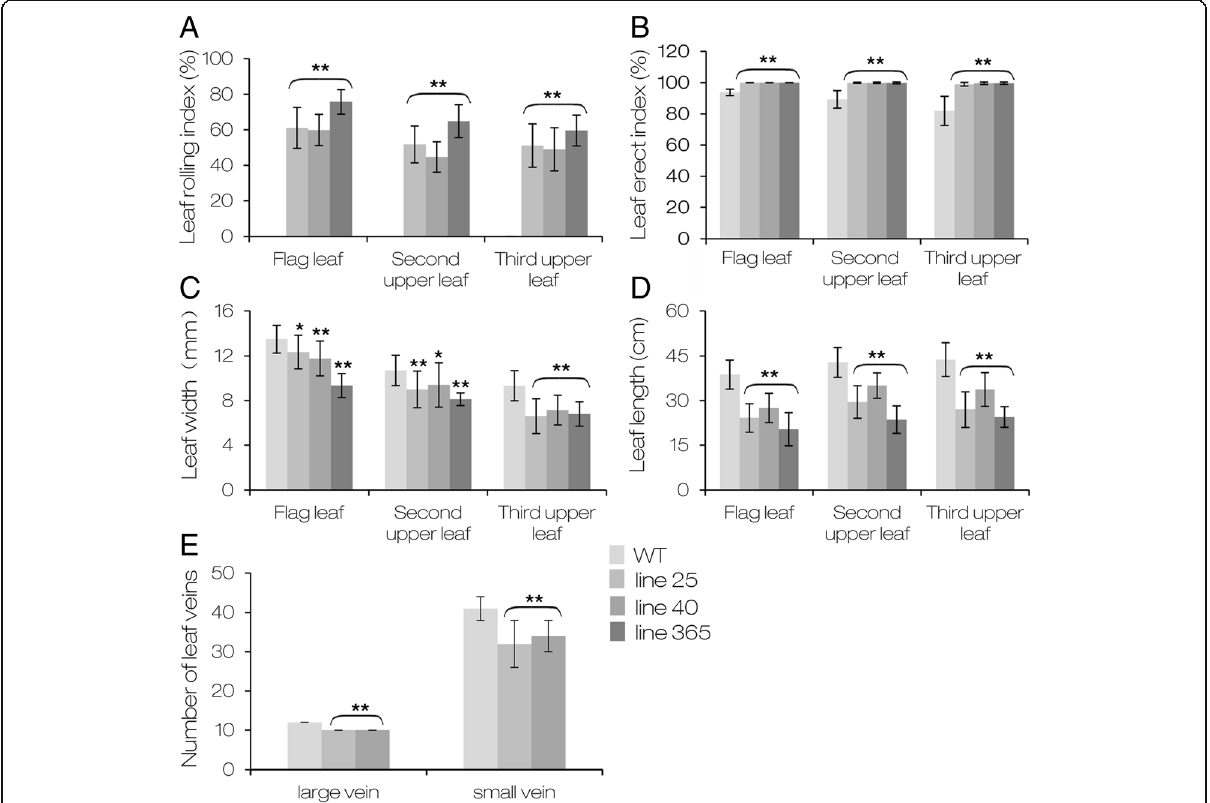
Fig. 2 Characteristics of wild type Zhonghua 11 and OE- AGO1b leaves. a , b Leaf rolling index (LRI) and leaf erect index (LEI) of ZH11 (WT) and OE- AGO1b (line 25, line 40, line 365) leaves. c , d Leaf width and leaf length of WT and OE- AGO1b leaves. e Number of leaf veins of WT and OE- AGO1b leaves. Flag leaves at the grain-filling period were used. Results are shown as the mean±SD in ( a )-( e ) ( n =10). * P <0.05, ** P <0.01 (one-way